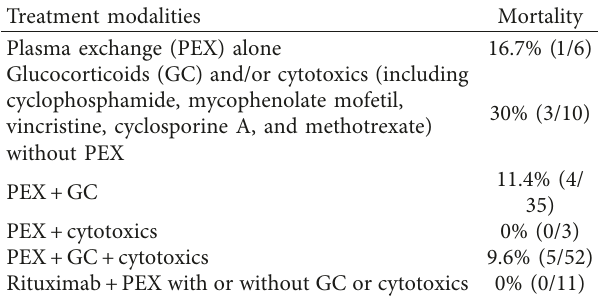
Table 3: Treatment modalities and